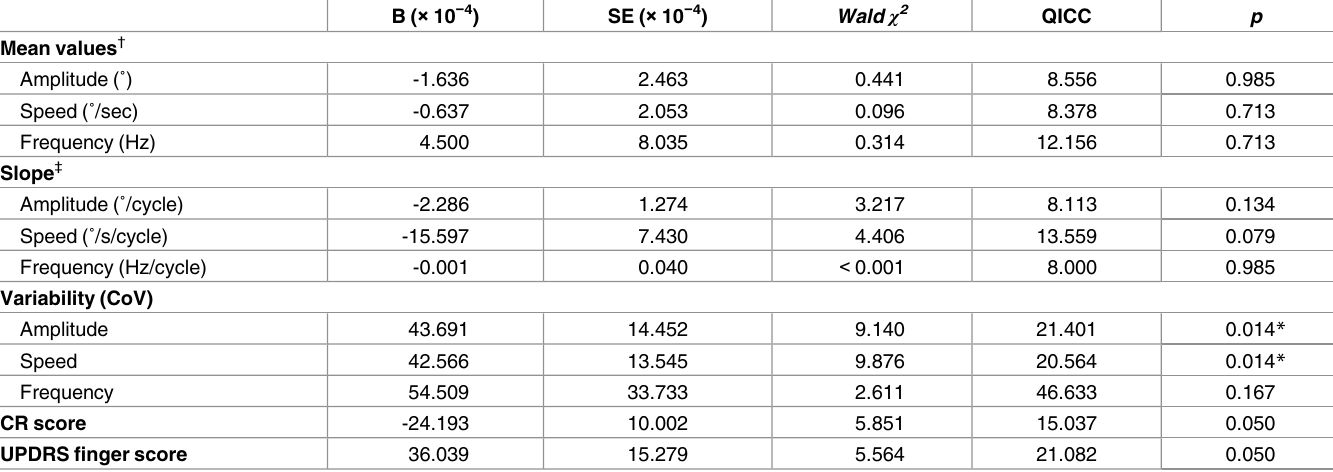
Table 2. Impact of TDT prolongation on kinematic parameters of finger tapping in PD